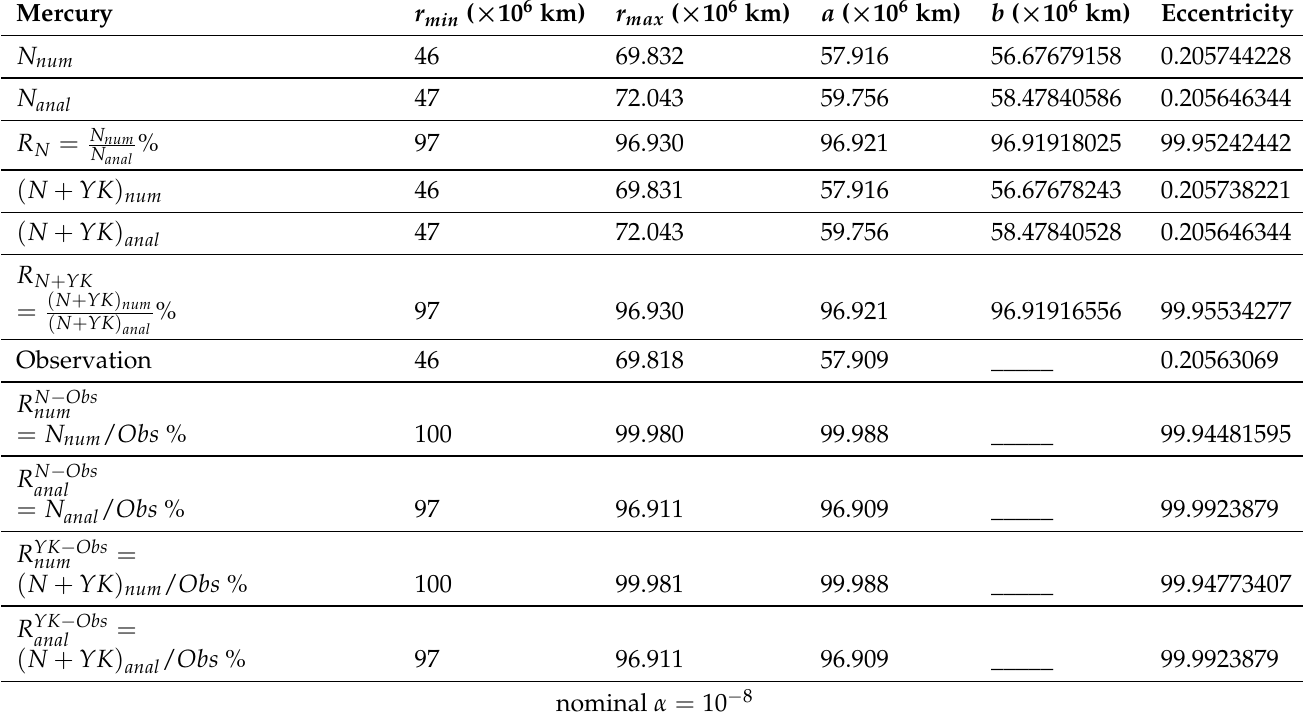
Table A1. The values of the calculated and observational astronomical parameters, for nominal α , of the planet Mercury, whose number of moons is